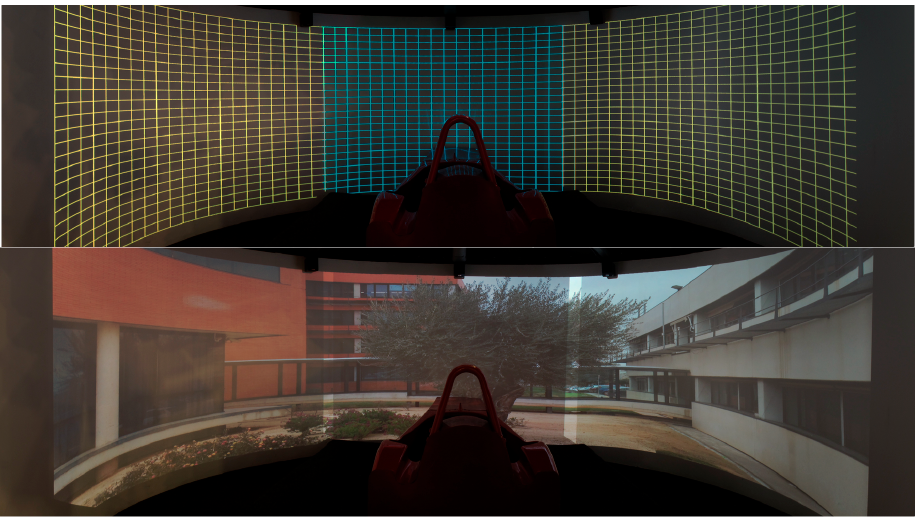
Figure 8. Panoramic views of the resulting wall-paper like projections of a grid ( top ) and a scene ( bottom ). No photometric correction is applied in the overlapping areas to highlight the results of the method.